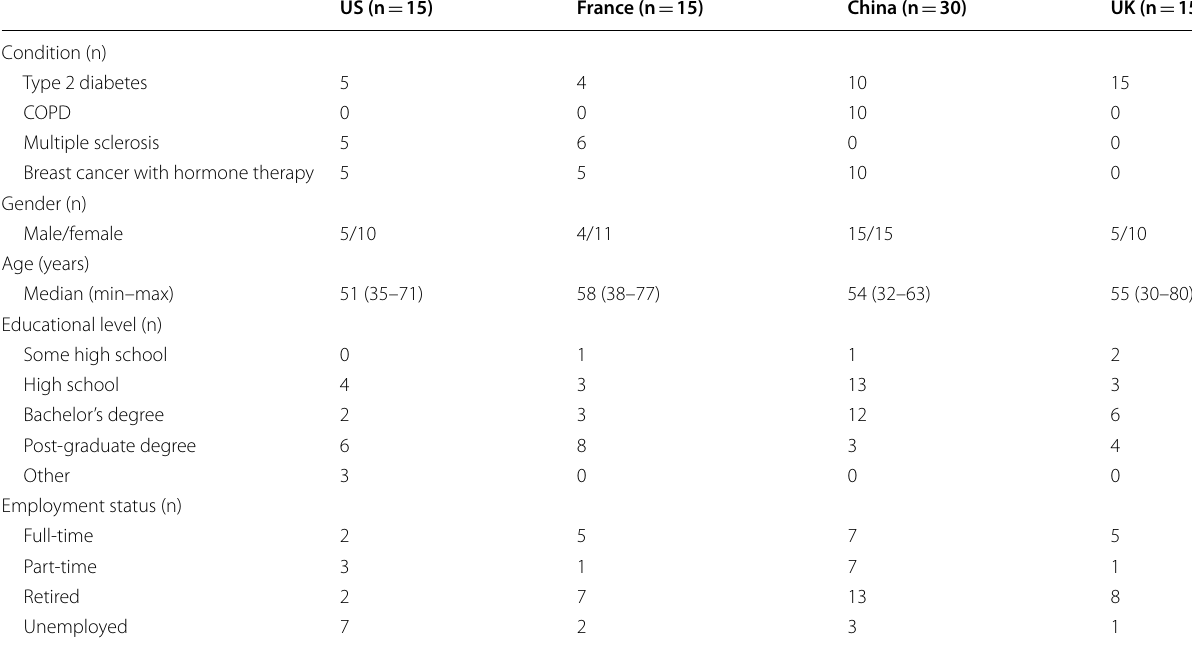
COPD chronic obstructive pulmonary